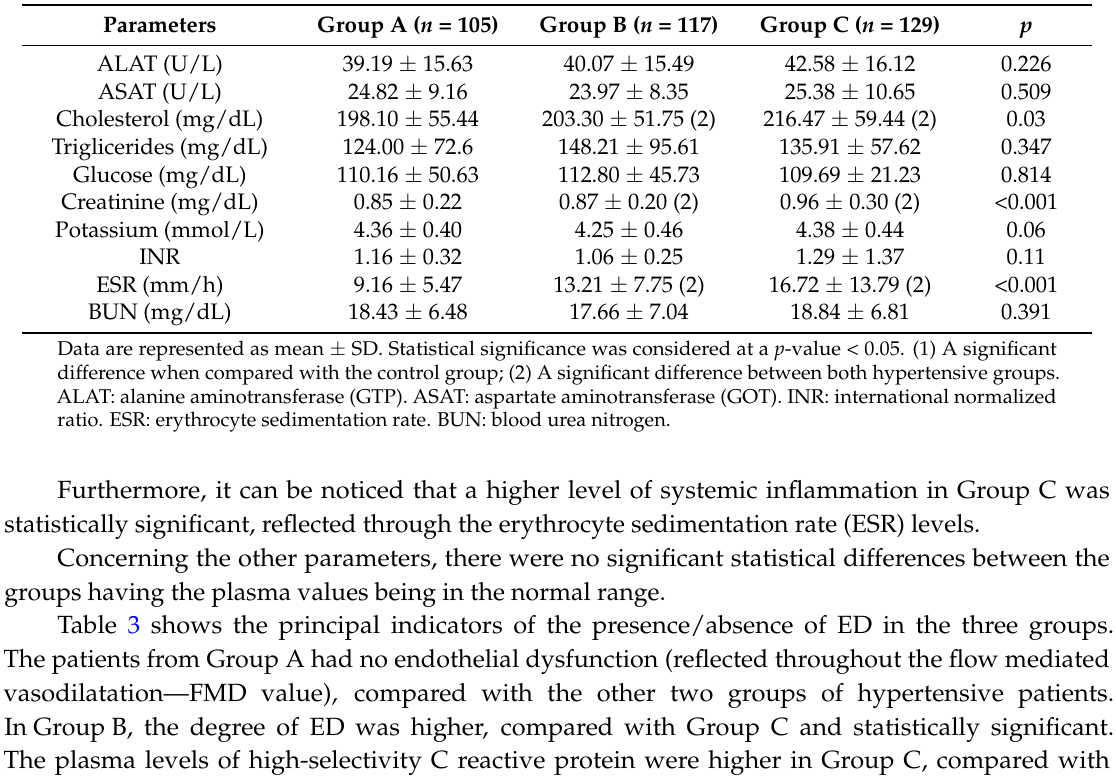
Table 2. Biochemical data among the patients in the study